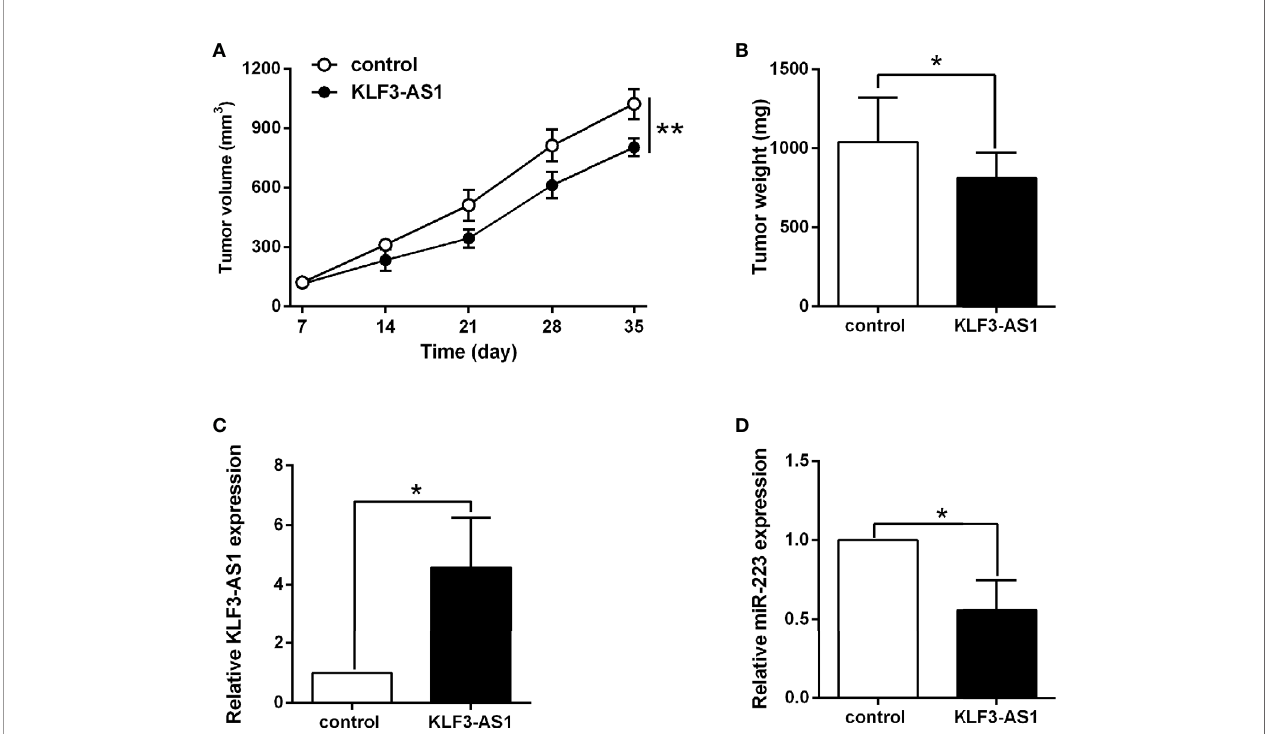
FIGURE 6 | KLF3-AS1 overexpression suppressed in vivo tumor growth of SGC-7901 cells. (A) The in vivo tumor growth of SGC-7901 cells transfected with pcDNA3.1 or pcDNA3.1-KLF3-AS1 was examined in the xenograft nude mice model. (B) The tumor weight of the dissected tumors was examined at the end of the experiment. (C) KLF3-AS1 and (D) miR-223 expression in dissected tumor tissues were examined by qRT-PCR (Student ’ s t-test). N = 6; *P < 0.05 and **P <